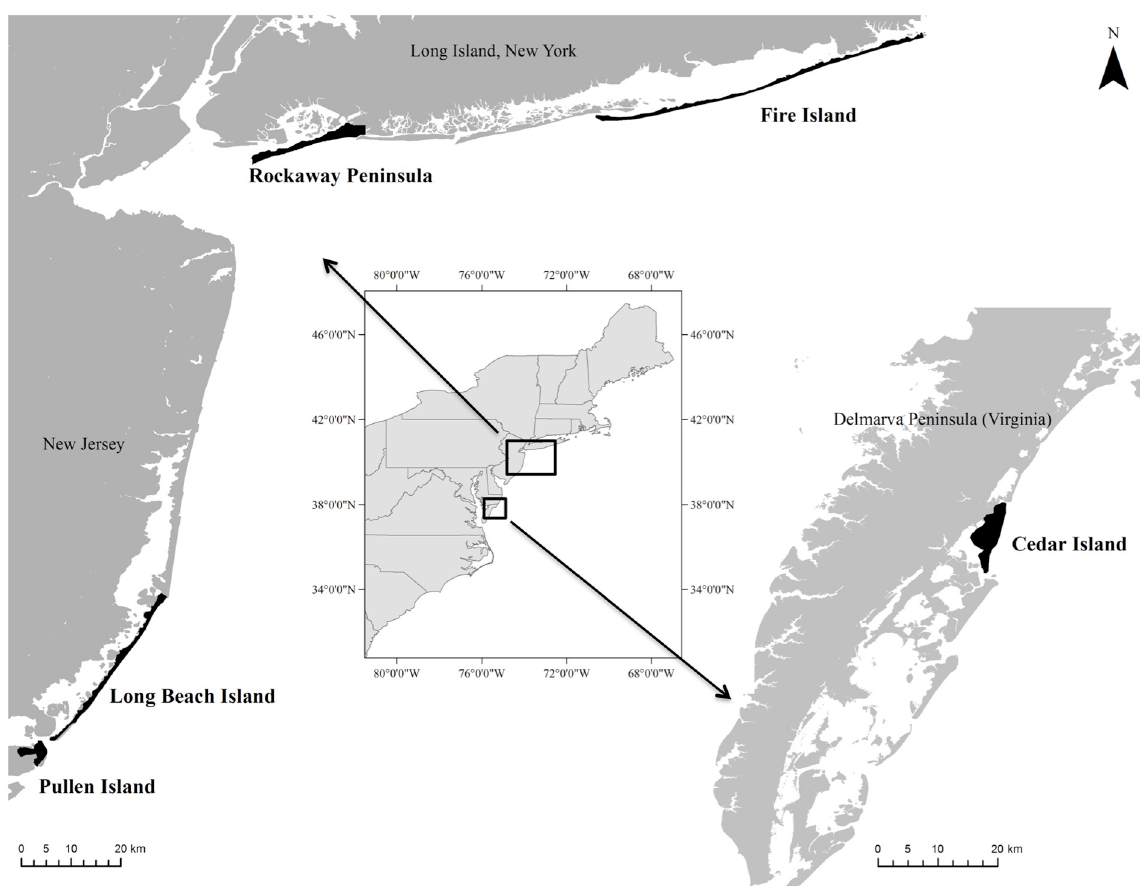
Fig 1. Study sites off the coasts of New York (Rockaway Peninsula, Fire Island), New Jersey (Pullen and Long Beach islands), and Virginia (Cedar Island) USA, where we modeled piping plover habitat before and after Hurricane Sandy using a Bayesian network approach.